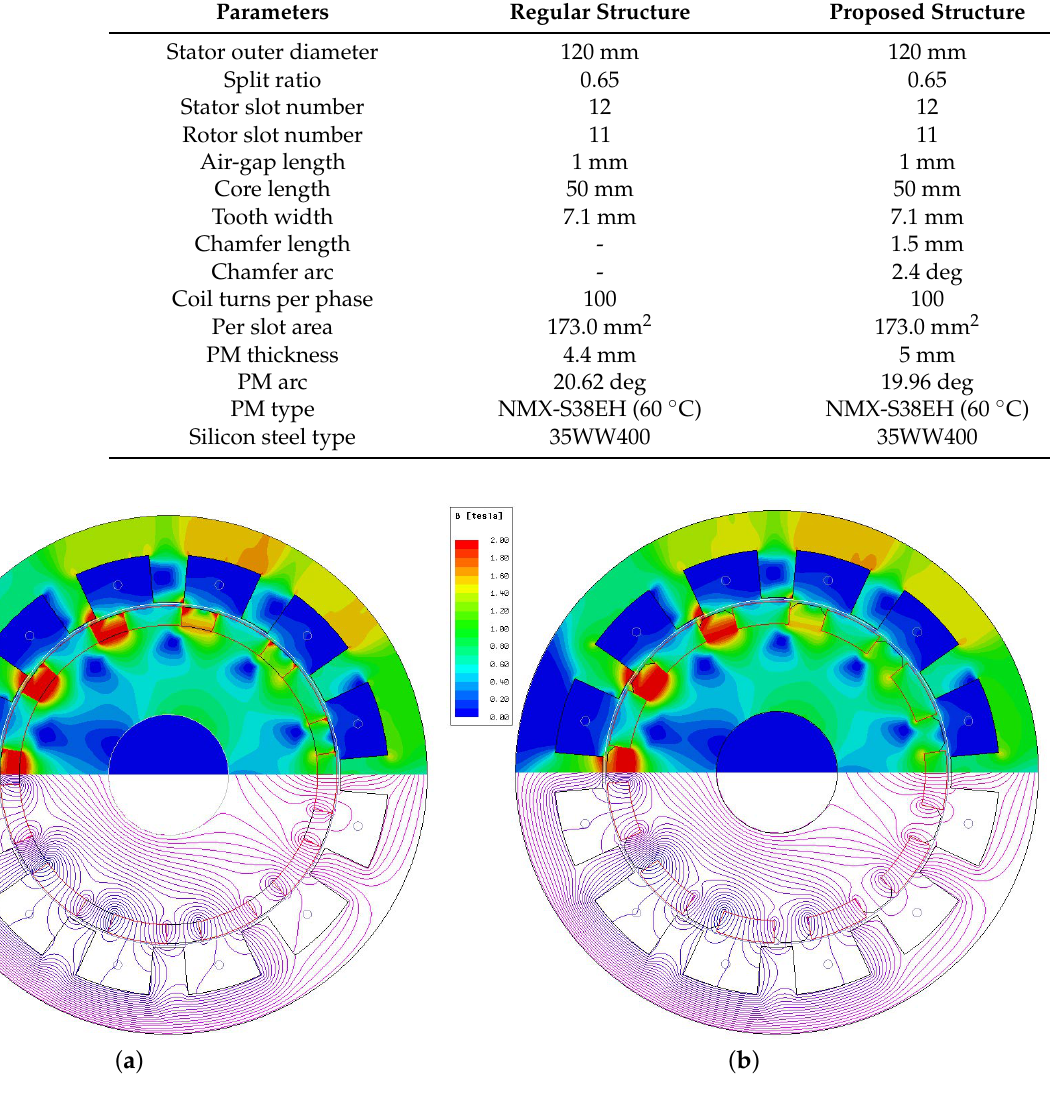
Figure 7. Flux contour distributions of both candidates under 20 W copper loss. ( a ) Regular machine; ( b ) Proposed